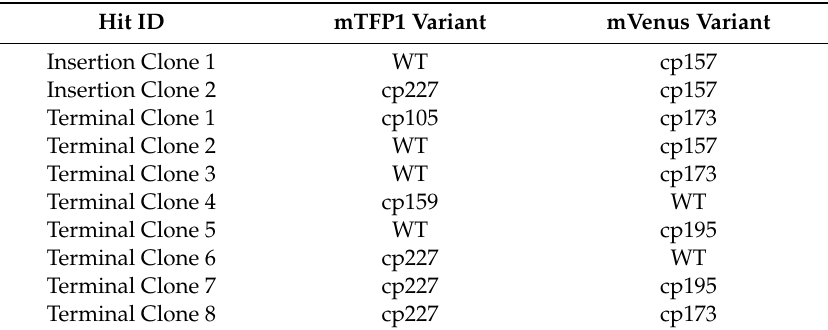
Figure 3. Library screening results. Results are shown for the ( a ) insertion-fusion, ( b ) terminal-fusion, ( c ) linker length, and ( d ) polyproline linker composition library screens. The y-axis values represent the fold change in the mTFP1 / mVenus FRET ratio after KCN addition relative to baseline measurements for live-cell suspensions. Each symbol represents the result for a culture grown from a single clone in the library, and the responses of individual clones are plotted along the x-axis according to Clone #. The blue squares represent the response of the ATeam1.03 ATP sensor as a control. The red diamonds represent “hits” in which a response was both ratiometric and could be reproduced, except in ( d ) where the red diamond represents the response of the best hit from the library in ( c ) as a control. Table 1. The fluorescent protein variants for example library screen